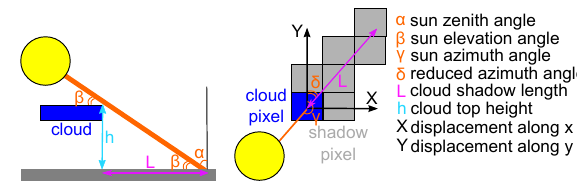
Fig. 4. Derivation of cloud shadow. For details see Sect.